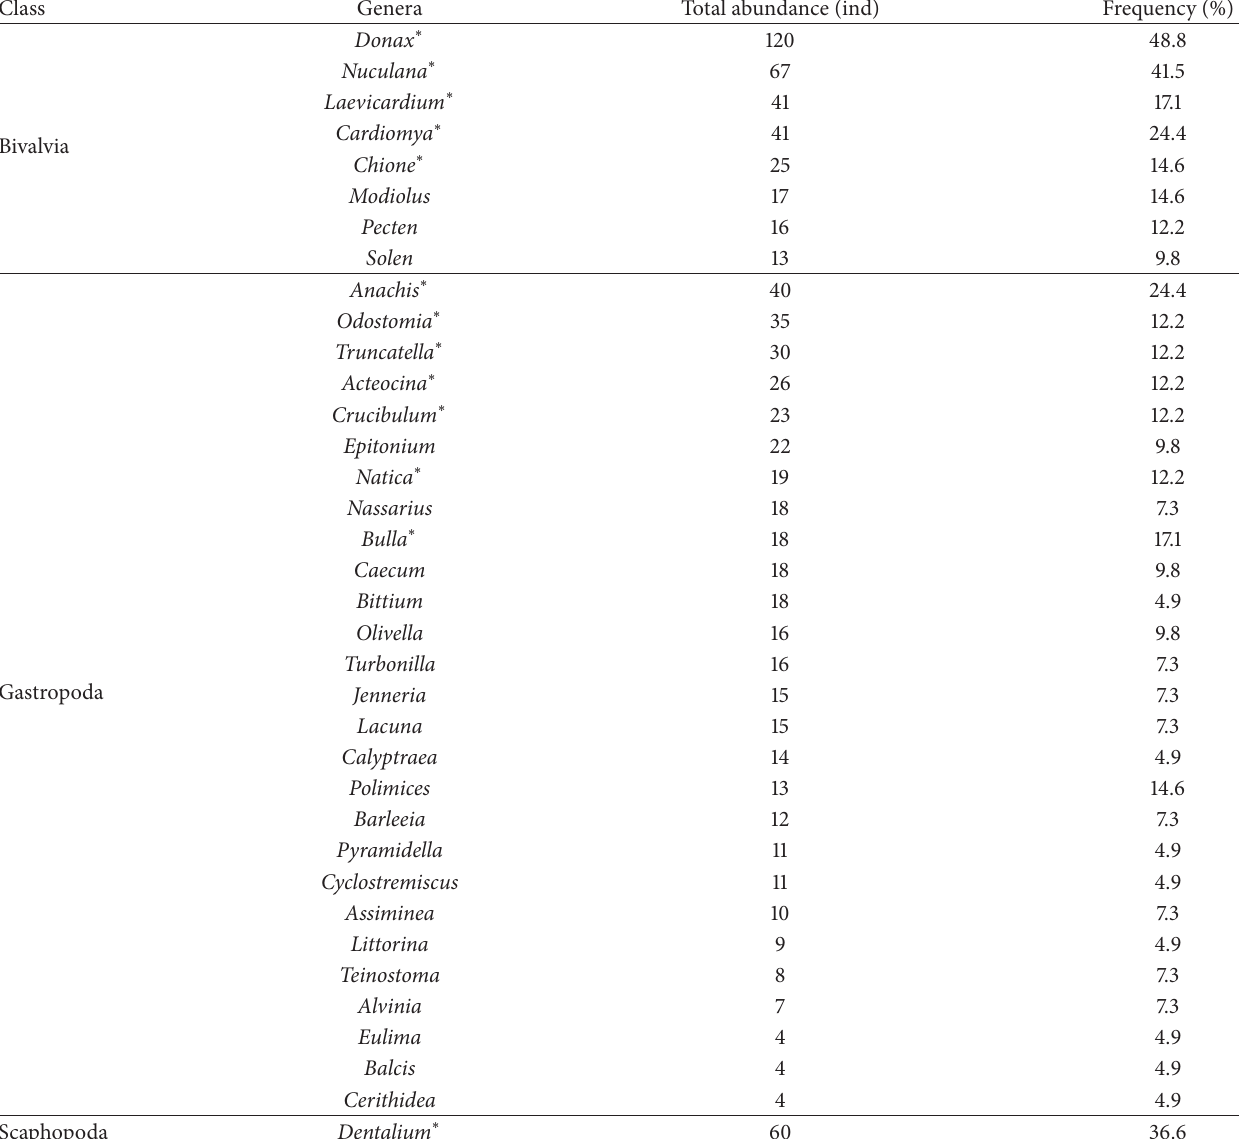
Table 3: Abundance and frequency of mollusks in Todos Santos Bay. Dominant genera ∗ .